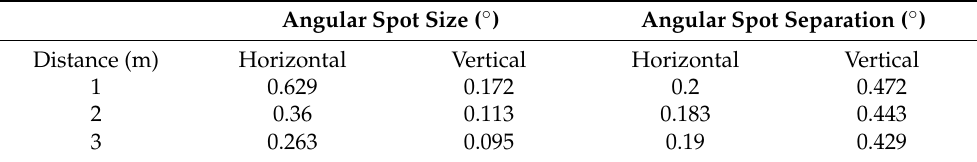
Table 2. Diffraction efficiency of the